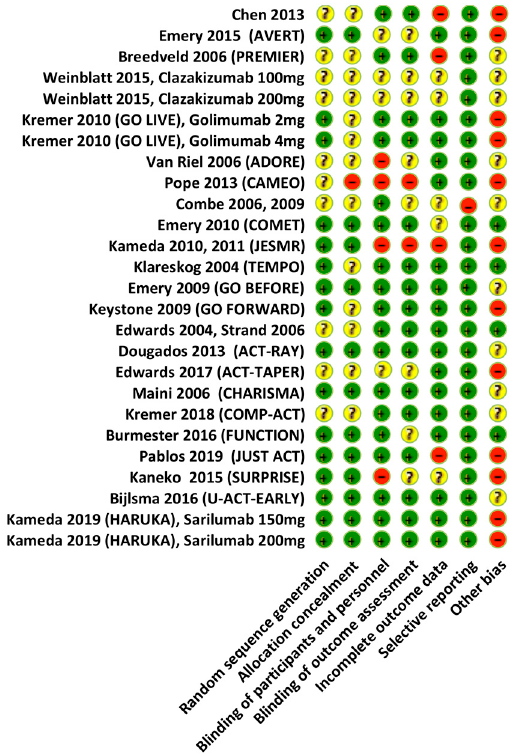
Figure 1. Assessment of the risk of bias. The Cochrane Collaboration tool used for randomized trials.